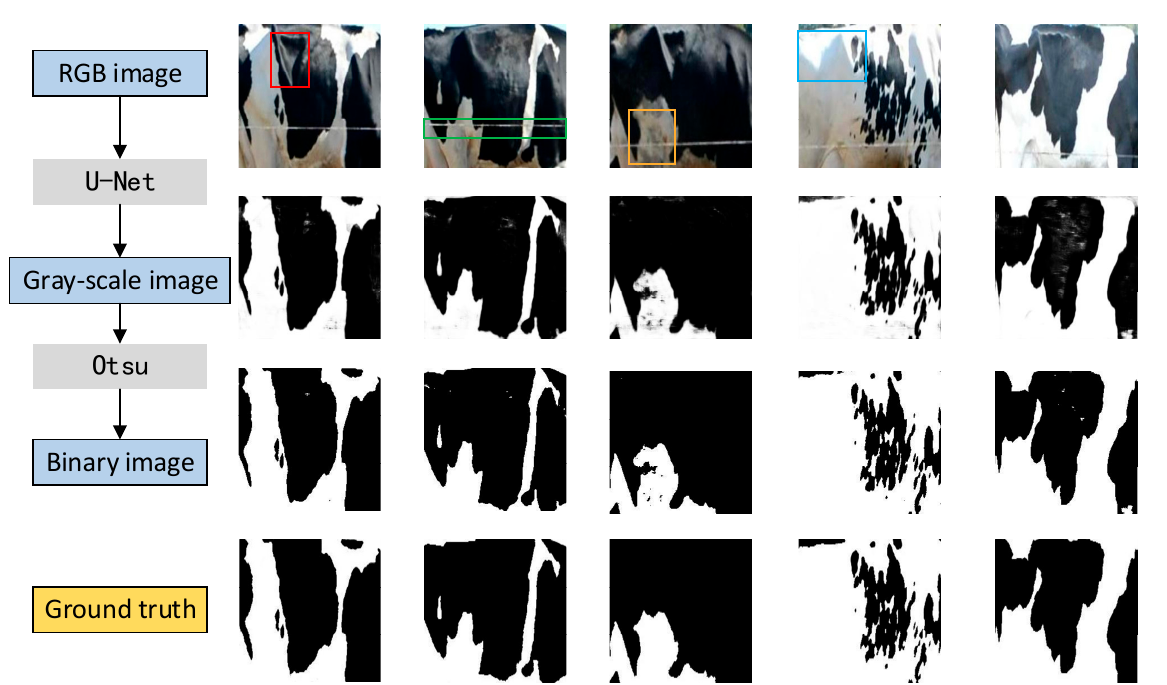
Figure 9. Binarization segmentation results of cow body pattern images. In the figure, the images in the first row are the RGB body pattern images to be processed; the images in the second row are the gray images after U-Net segmentation; the images in the third row are the binary images after Otsu processing; and the images in the fourth row are the ground truths for comparison. The colored rectangular box in the figure marks some areas with interference.